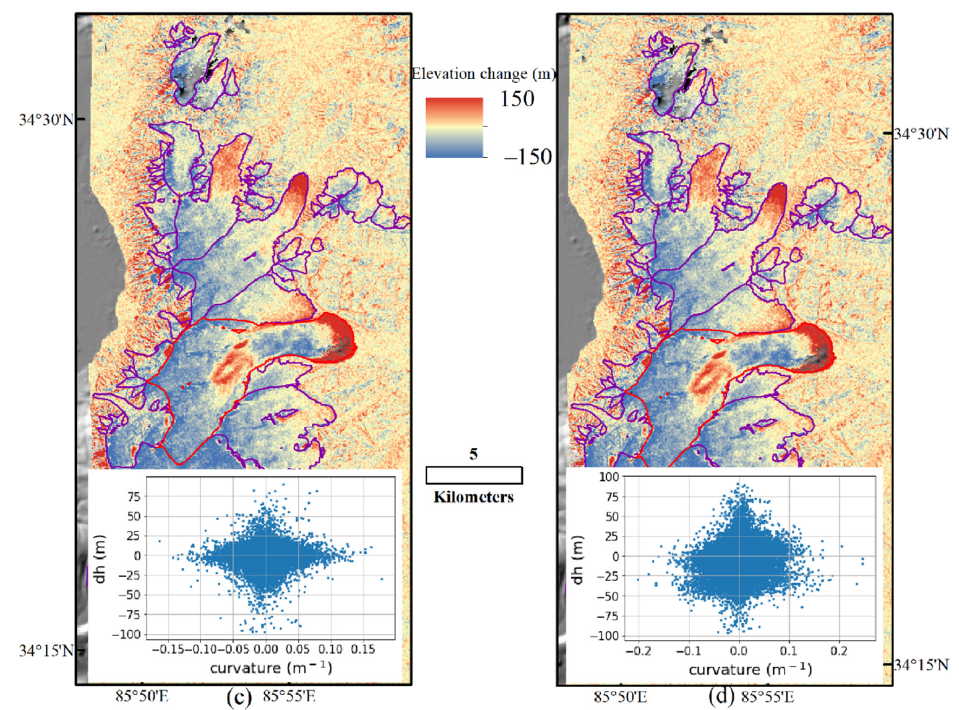
Figure A5. Elevation difference maps before ( a , c ) and after ( b , d ) the curvature correction. ( a ) and ( b ) difference maps of TDM and SRTM; ( c ) and ( d ) difference maps of HMA and SRTM. Y and X axes of inner scatter plots represent the elevation difference and the maximal curvature, respectively.